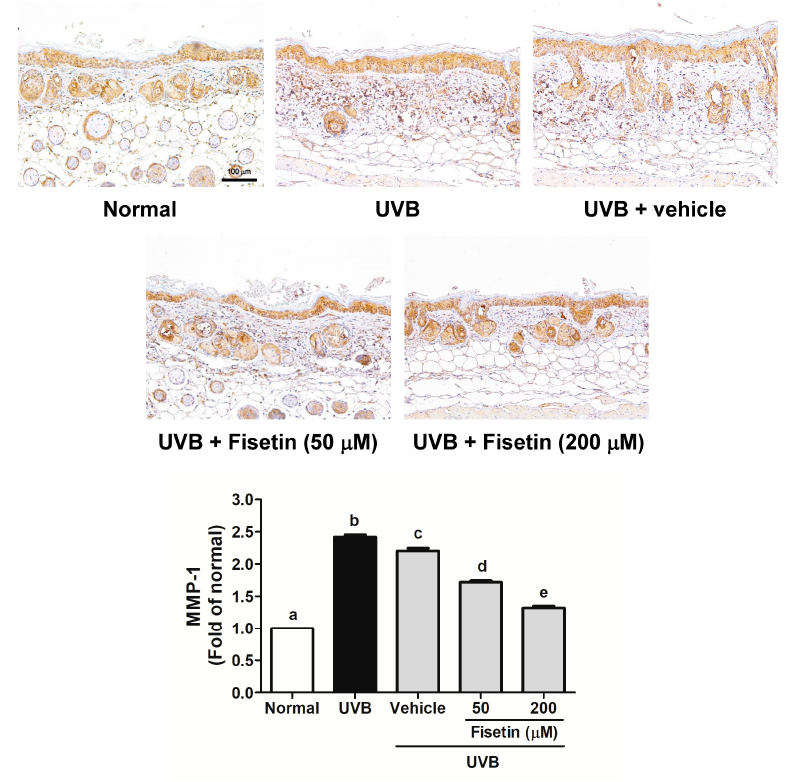
Figure 7. Immunohistochemical staining of MMP-1 expression in the dermis of the mouse skin slices. Fisetin inhibits UVB-induced MMP-1 overexpression (200×). a–e: Values not followed by a common letter are significantly different ( p <